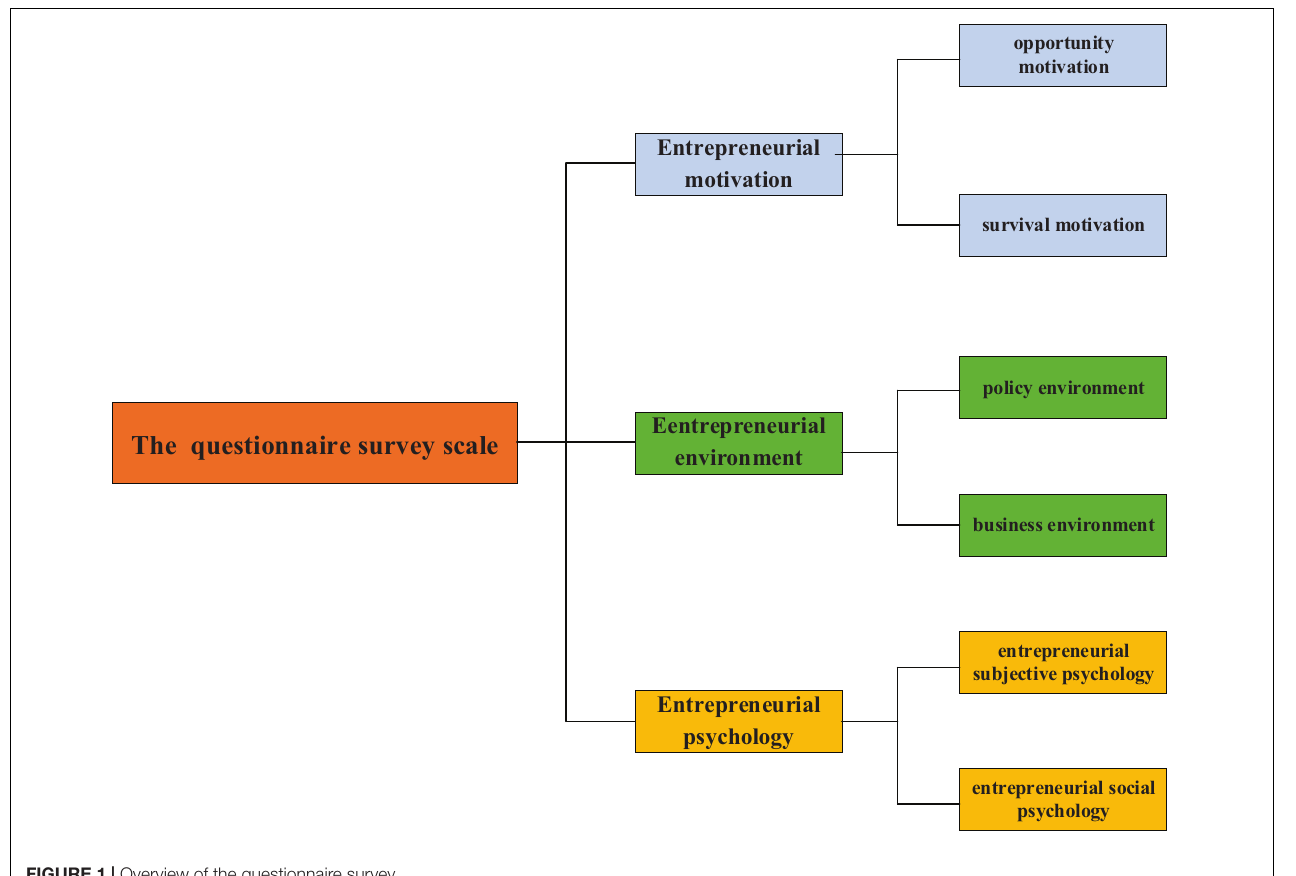
FIGURE 1 | Overview of the questionnaire survey.